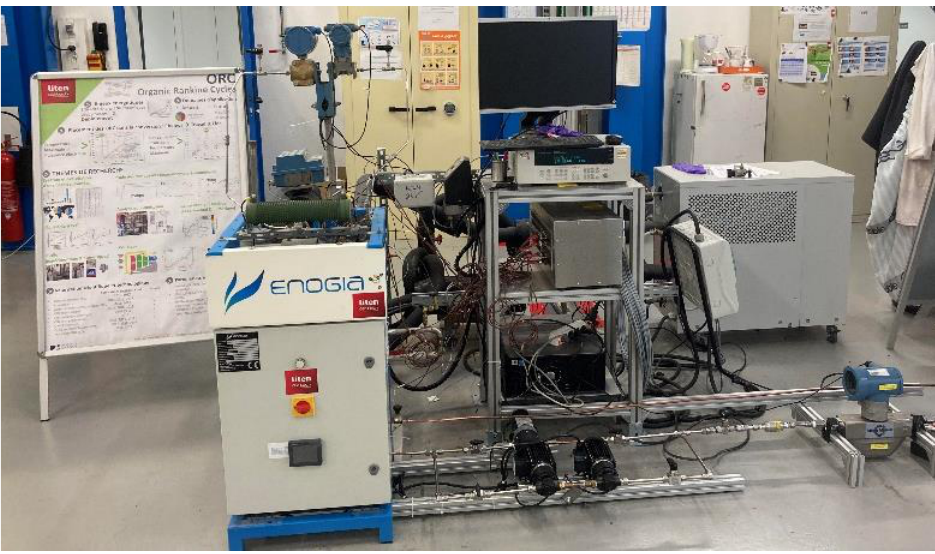
Figure 5. Experimental test bench.